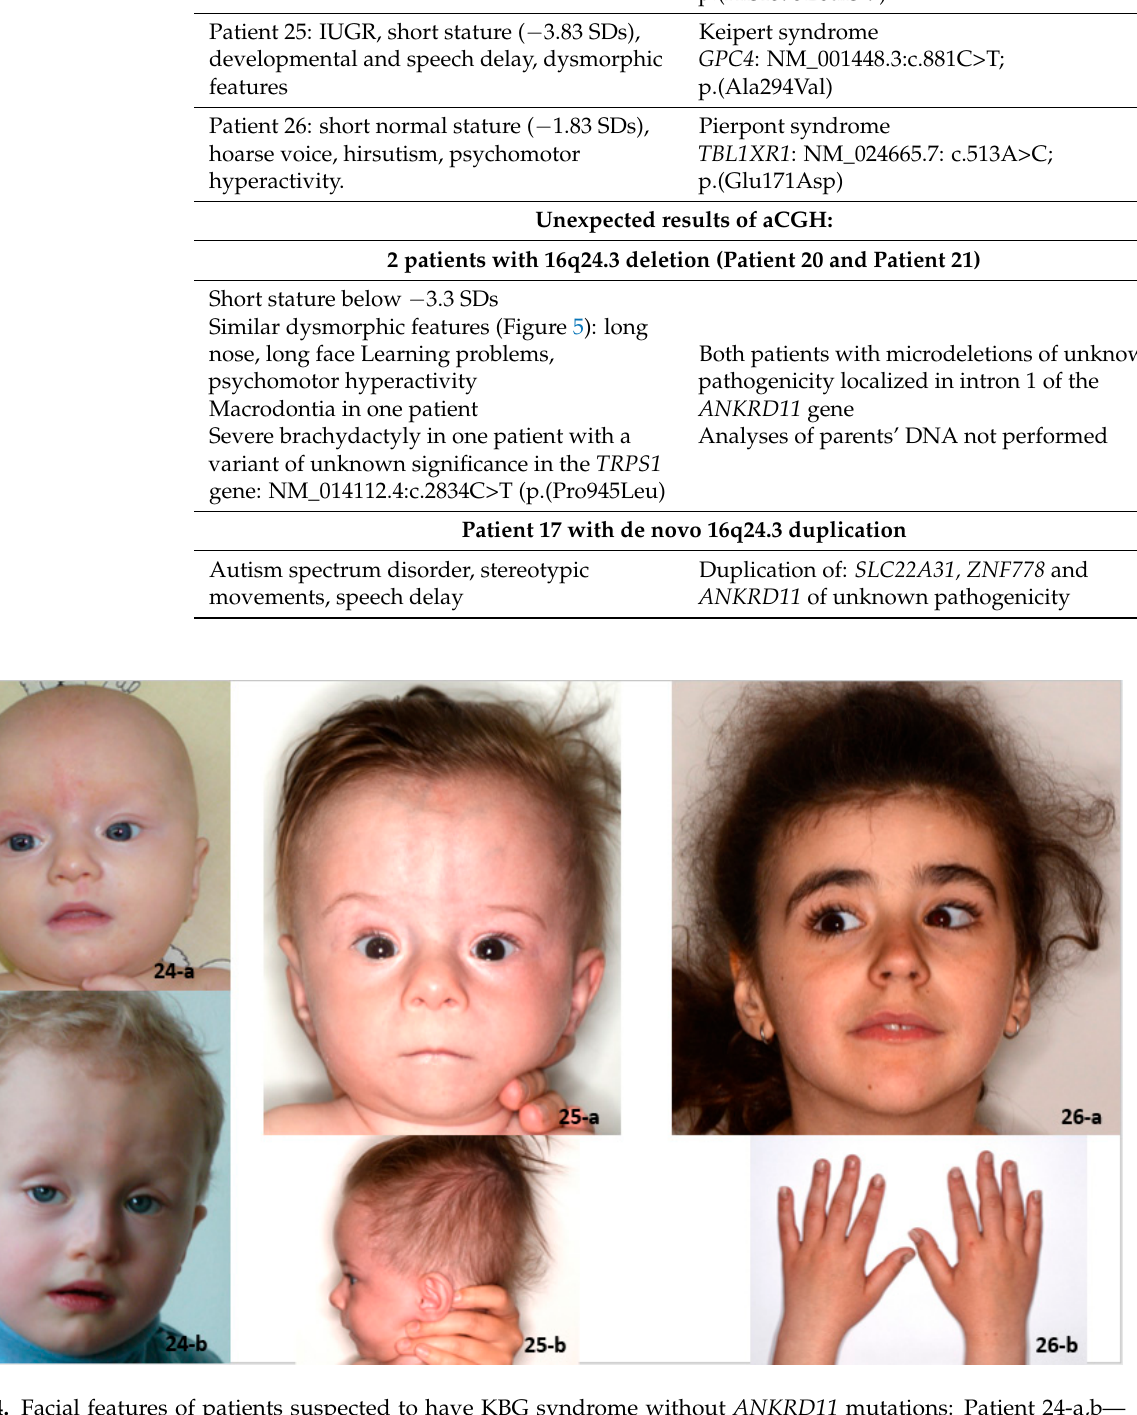
Figure 5. Patient 20 with short stature below − 3.3 SDs, with microdeletion in the ANKRD11 gene localized in intron1 and with a variant in the TRPS1 gene of unknown pathogenicity.